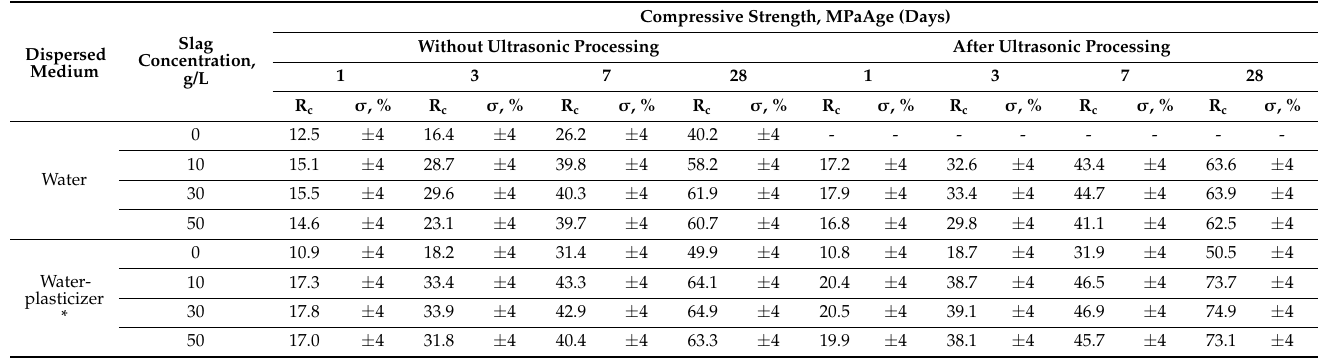
Table 26. Strength characteristics of SPC-based samples with slag suspension.